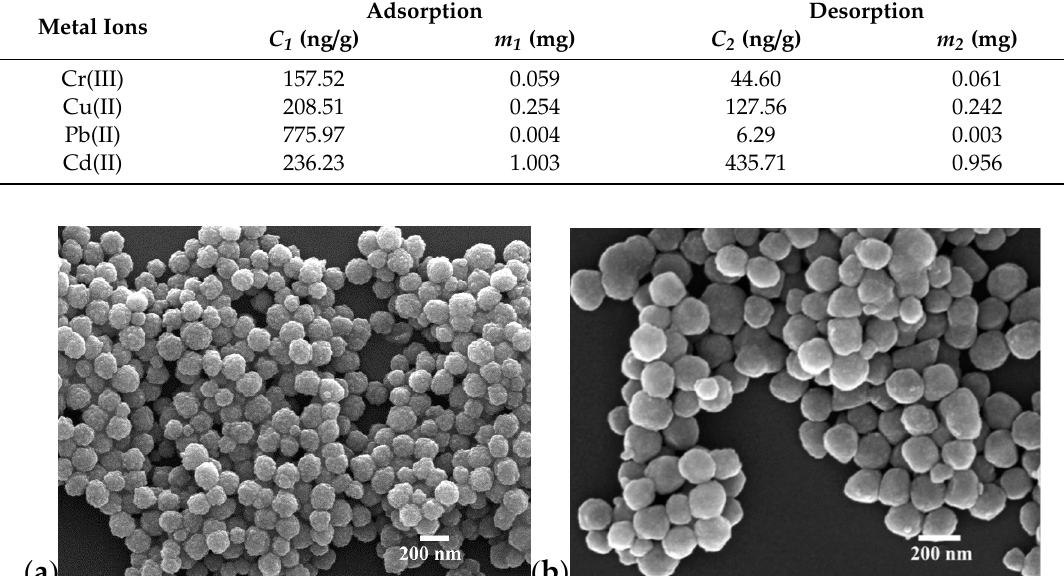
Figure 6. SEM images of Fe 3 O 4 @Me 6 TREN NPs after ( a ) adsorption and ( b ) desorption of heavy metal ions, respectively; ( c ) adsorption capacity of NPs after recycling three times. 3. Materials and Methods 3.1. Materials Ferric chloride hexahydrate (FeCl 3 ·6H 2 O), ethylene glycol, ethylenediaminetetraacetic acid disodium salt (EDTA-Na 2 ), formaldehyde solution (38% in water), sodium acetate, anhydrous cupric sulfate (CuSO 4 ), lead denitrate (Pb(NO 3 ) 2 ), cadmium nitrate (Cd(NO 3 ) 2 ), and chromic chloride hexahydrate